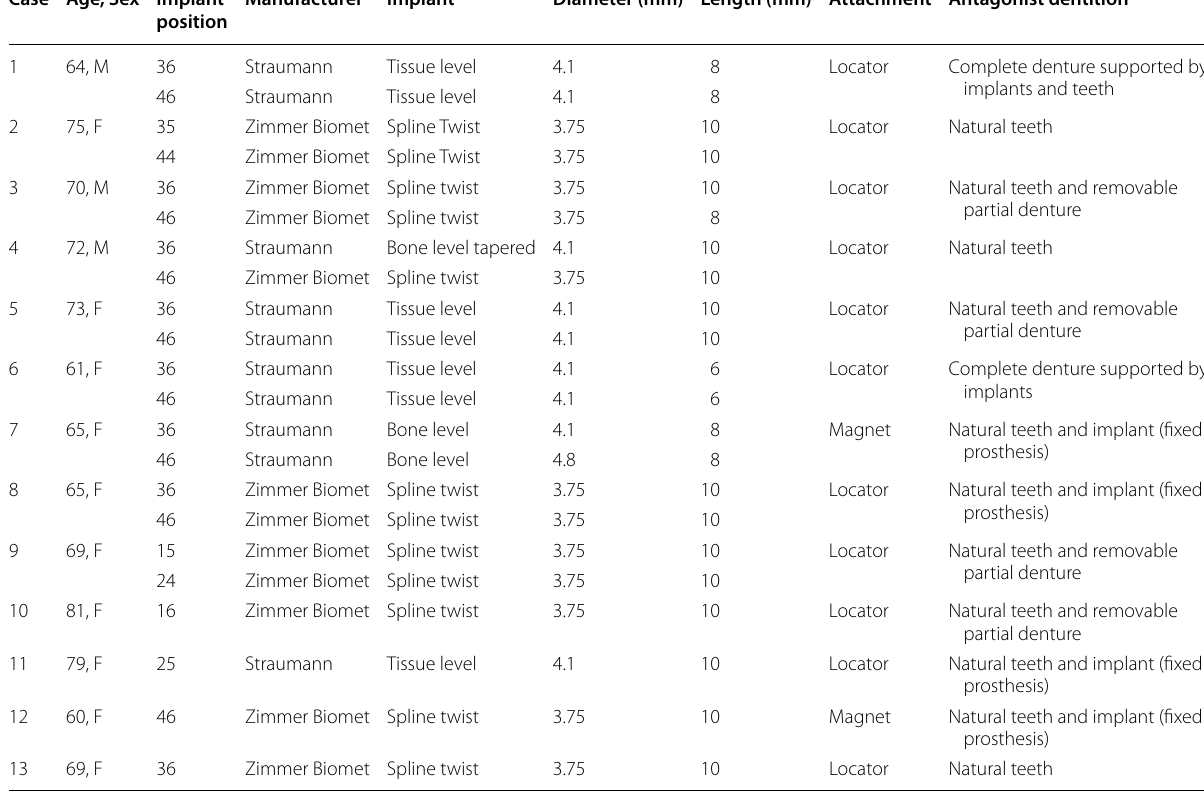
Table 1 Summary of subjects Case Age, Sex Implant Manufacturer Implant position